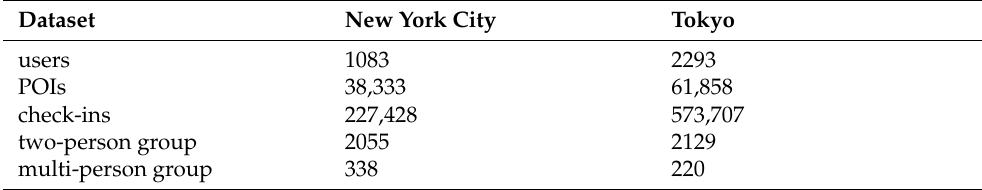
Table 2. Description information of the